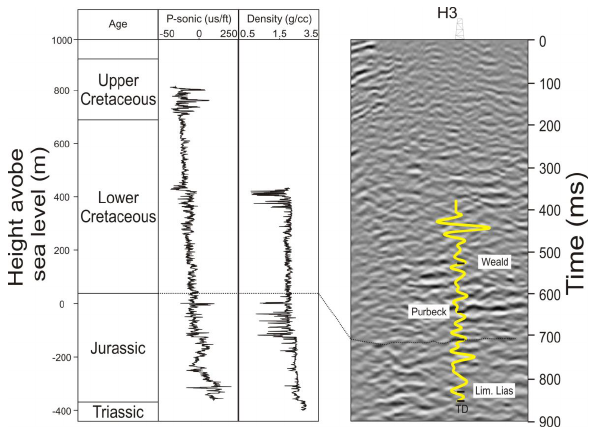
Fig. 14: Sonic and density logs of the H3 well in depth, with their interpreted age. A zero offset synthetic trace, calculated assuming a Ricker wavelet with a peak frequency Fig. 14. Sonic and density logs of the H3 well in depth, with their of 30 Hz is shown (yellow). The time-depth relationship for the synthetic was set interpreted age. A zero offset synthetic trace, calculated assuming a manually, due to the lack of check shot data and velocity information of the shallow Ricker wavelet with a peak frequency of 30Hz is shown (yellow). subsurface. The synthetic is overlain on a portion of the β-β’ section (location in Fig. 2 ). The time–depth relationship for the synthetic was set manually, due The Jurassic-Lower Cretaceous boundary is correlated with a dotted line. Main seismic to the lack of check shot data and velocity information of the shal- events are also labeled in the seismic section. low subsurface. The synthetic is overlain on a portion of the β - β 0 section (location in Fig. 2). The Jurassic–Lower Cretaceous bound- ary is correlated with a dotted line. Main seismic events are also labeled in the seismic section.